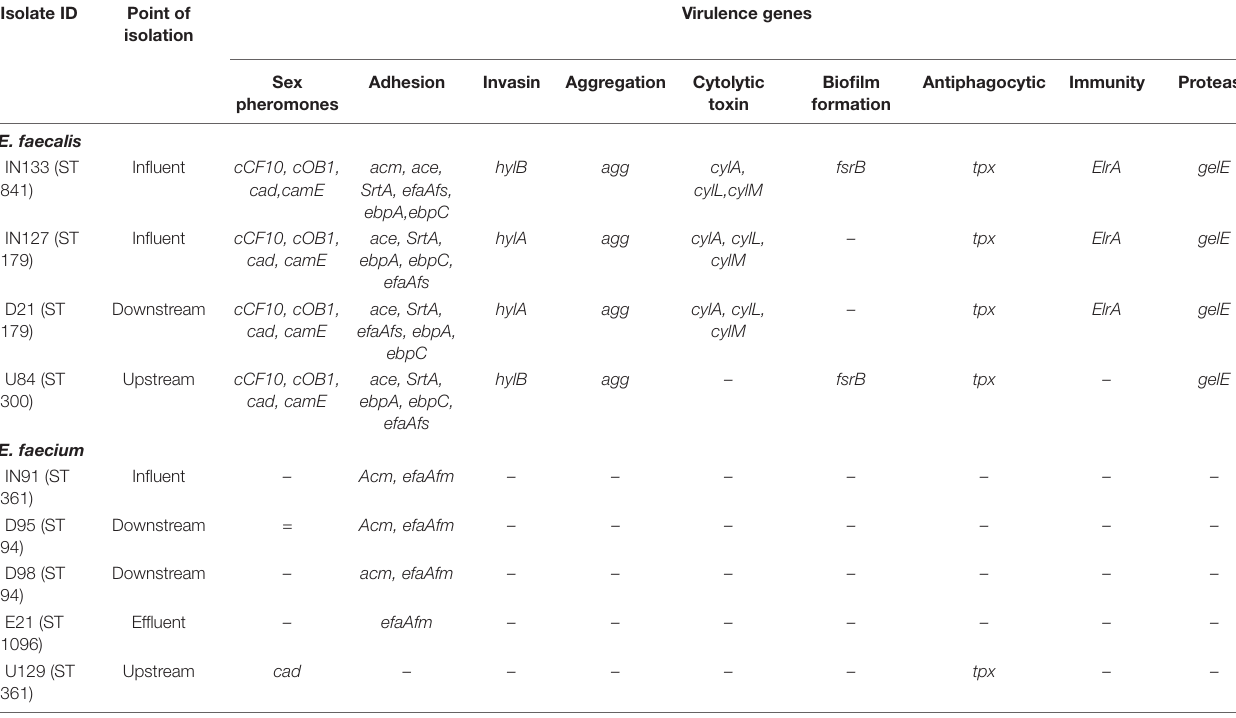
No virulence genes found in E. hirae and E. duran.